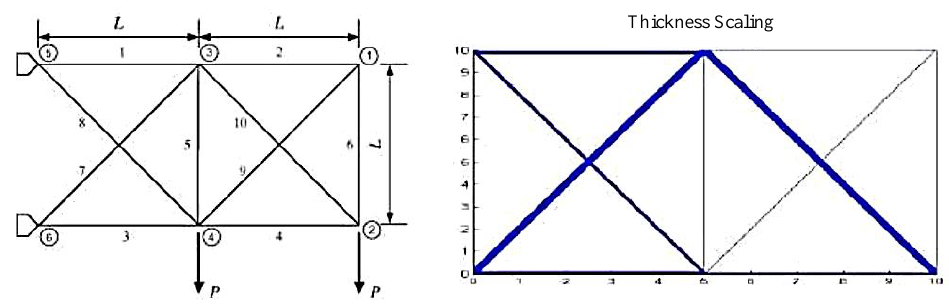
Figure 3. The design domain and the TO study